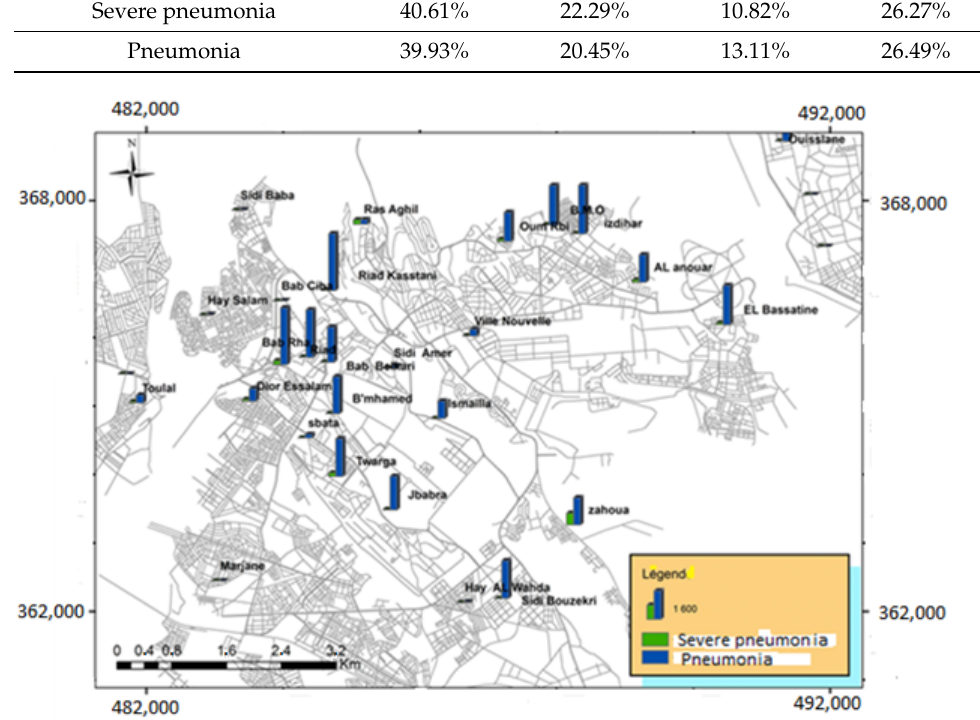
Figure 9. The annual average incidence of respiratory infection consultations (pneumonia and severe pneumonia) by the health center.